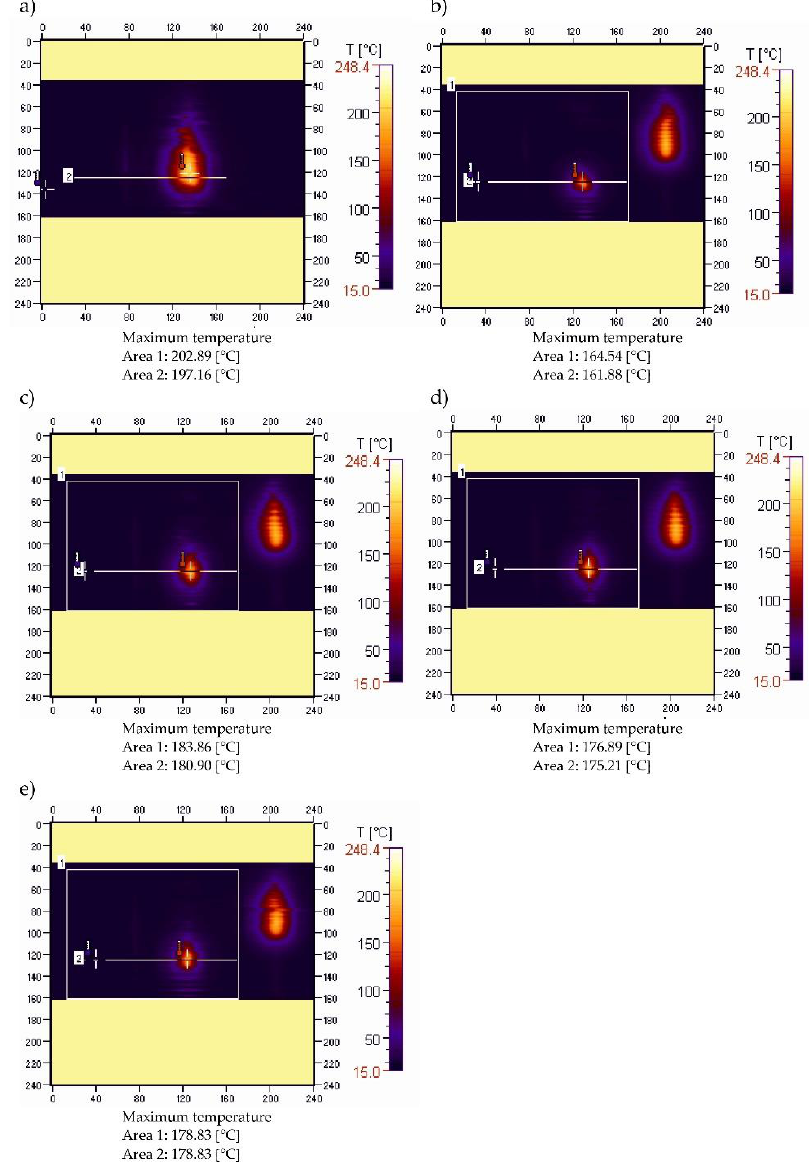
Figure 5. Thermograms of PBS sample recorded during ignition ( a ) and after: ( b )—15, ( c )—30, ( d )—45, ( e )—60 s after the ignition source was removed.